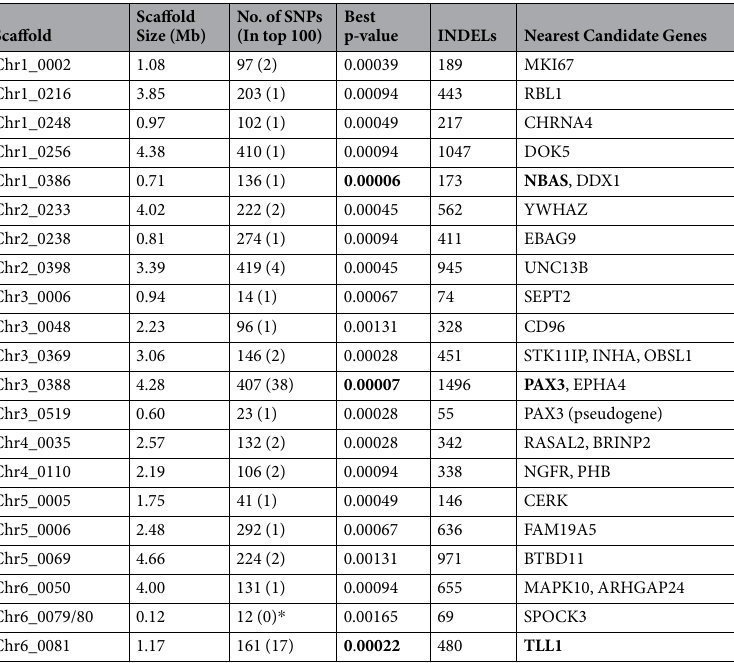
Table 1. Summary of loci segregating with DFTD regression identified by GWAS. Key candidate genes for DFTD regression are in bold. * Included as scaffolds contains annotations for neighbouring genes of TLL1 (identified by GWAS) and corresponding to a syntenic block as identified by comparison with human, mouse and opossum.